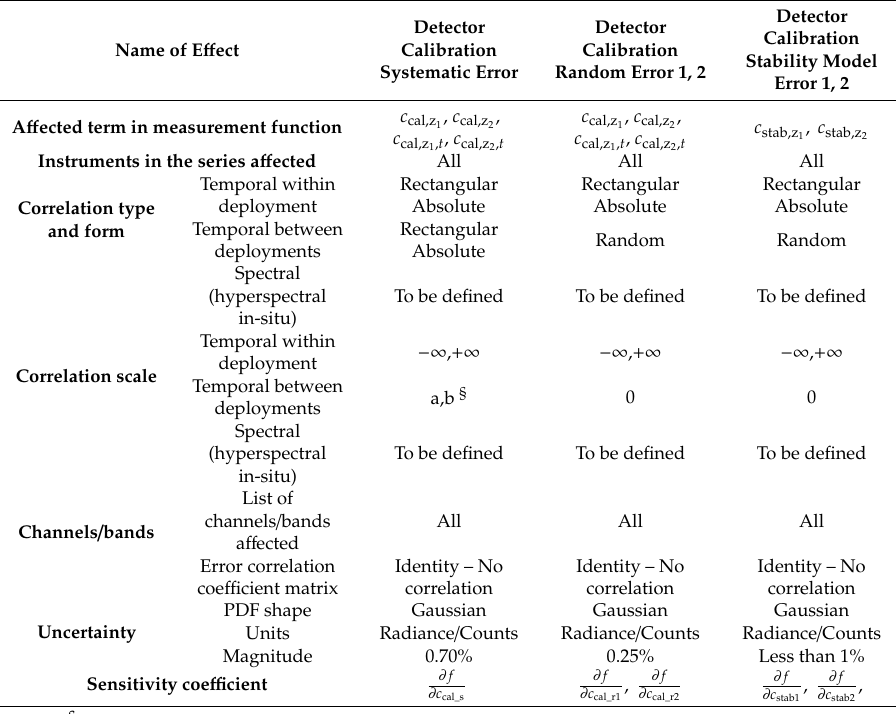
Table A3. E ff ects table for detector